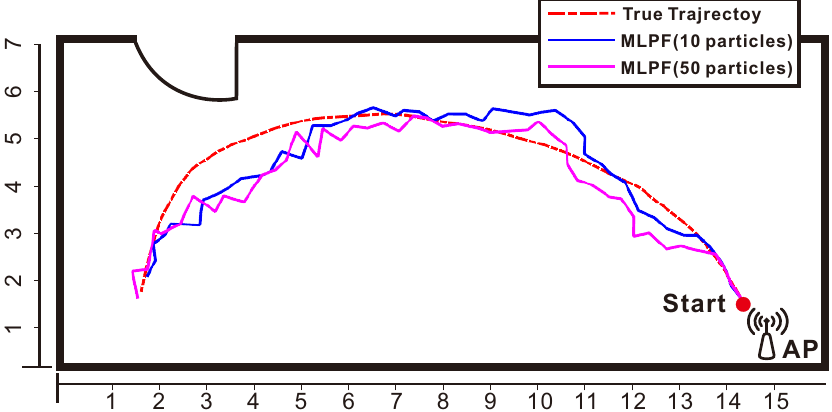
Figure 5. Tracking result of maximum likelihood particle filter (MLPF) with 10 and 50 particles in an empty